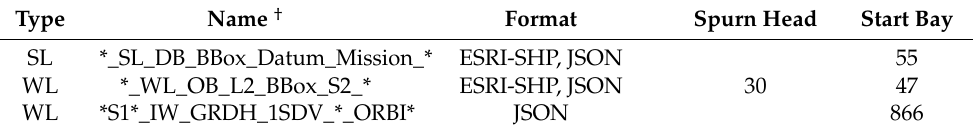
Table 1. Summary of file names, formats and number of EO products at each Site used for this study.